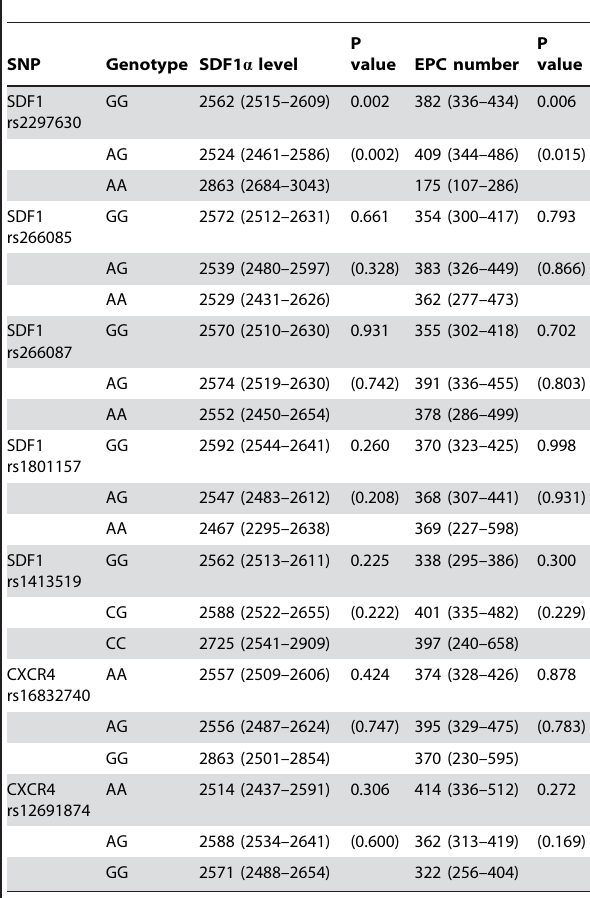
Table 3. Plasma SDF1 a levels and circulating EPC numbers according to SDF1 and CXCR4 SNP genotypes.